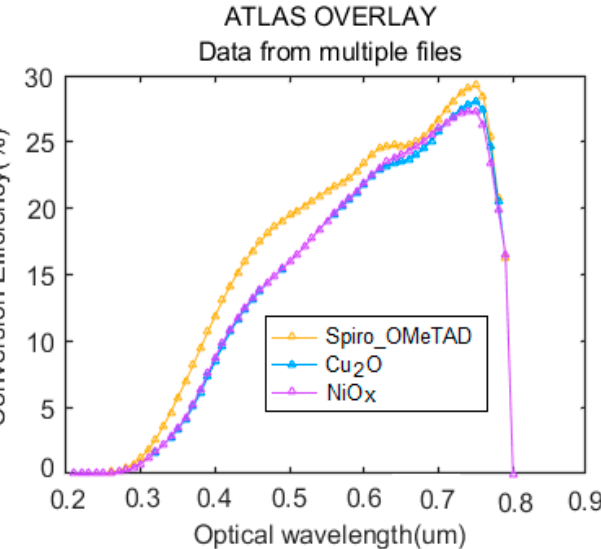
Figure 7. Effect of three different HTMs on the efficiency of inverted planar PSC using the ZnO electron-transporting